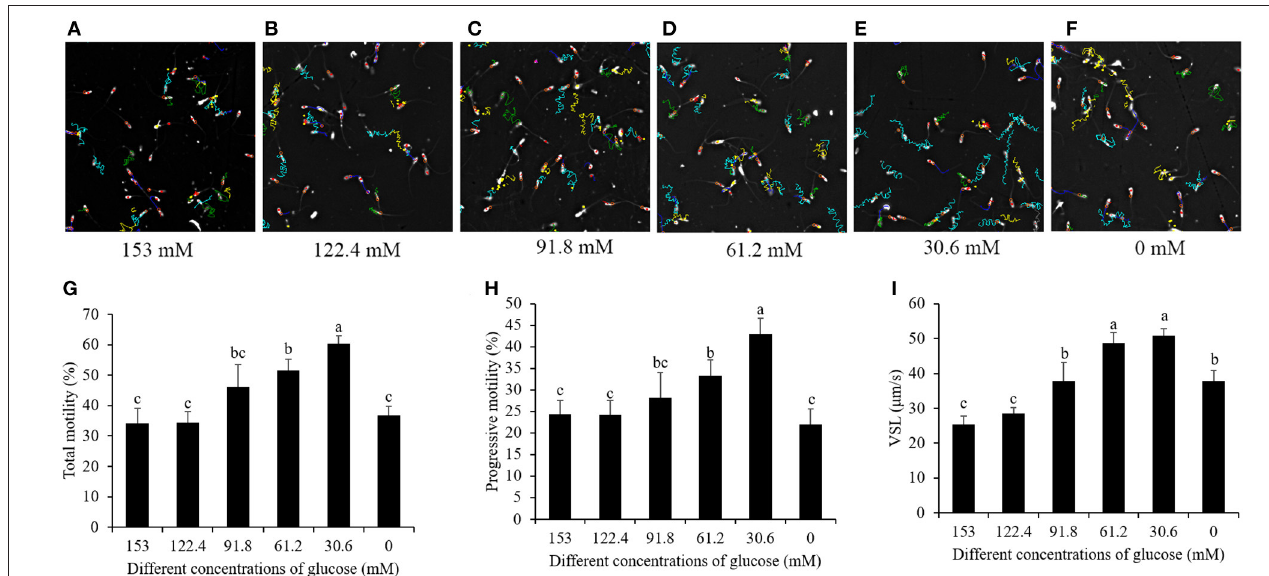
FIGURE 3 | Computer-assisted sperm motility analysis-derived changes of post-thaw sperm motility track by reducing the glucose level in the pretreatment solution from 153 to 0mM (A–F) . Effects of glucose level in the pretreatment solution on post-thaw sperm total motility (G) , progressive motility (H) , and VSL (I) . Values are specified as mean ± standard deviation. Columns with different lowercase letters differ significantly. VSL, straight line velocity.